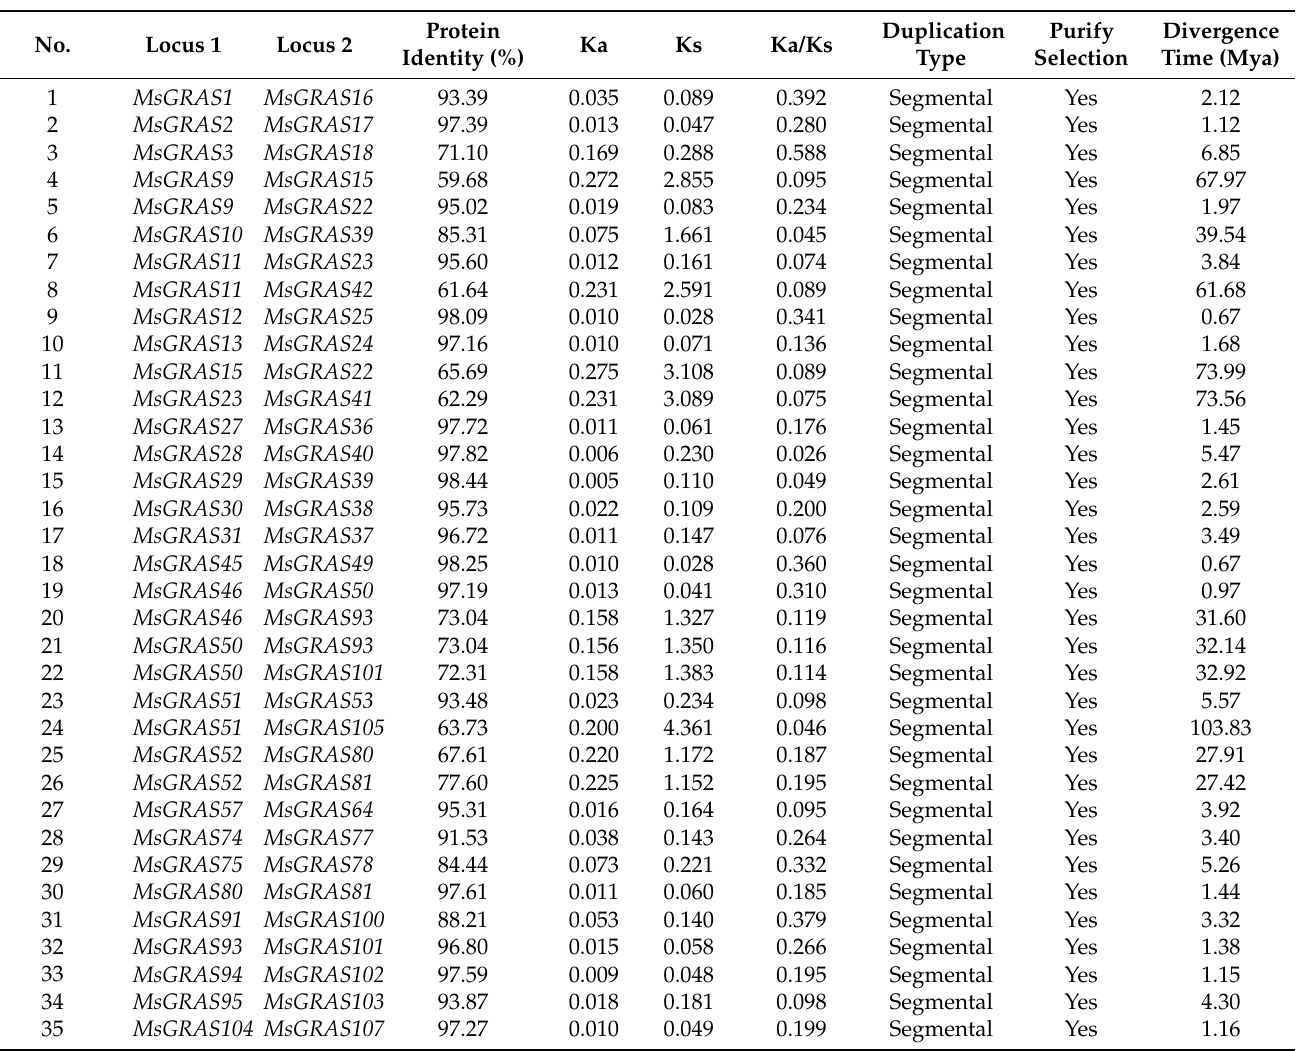
Table 2. Ka/Ks ratio of paralogous pairs of MsGRAS